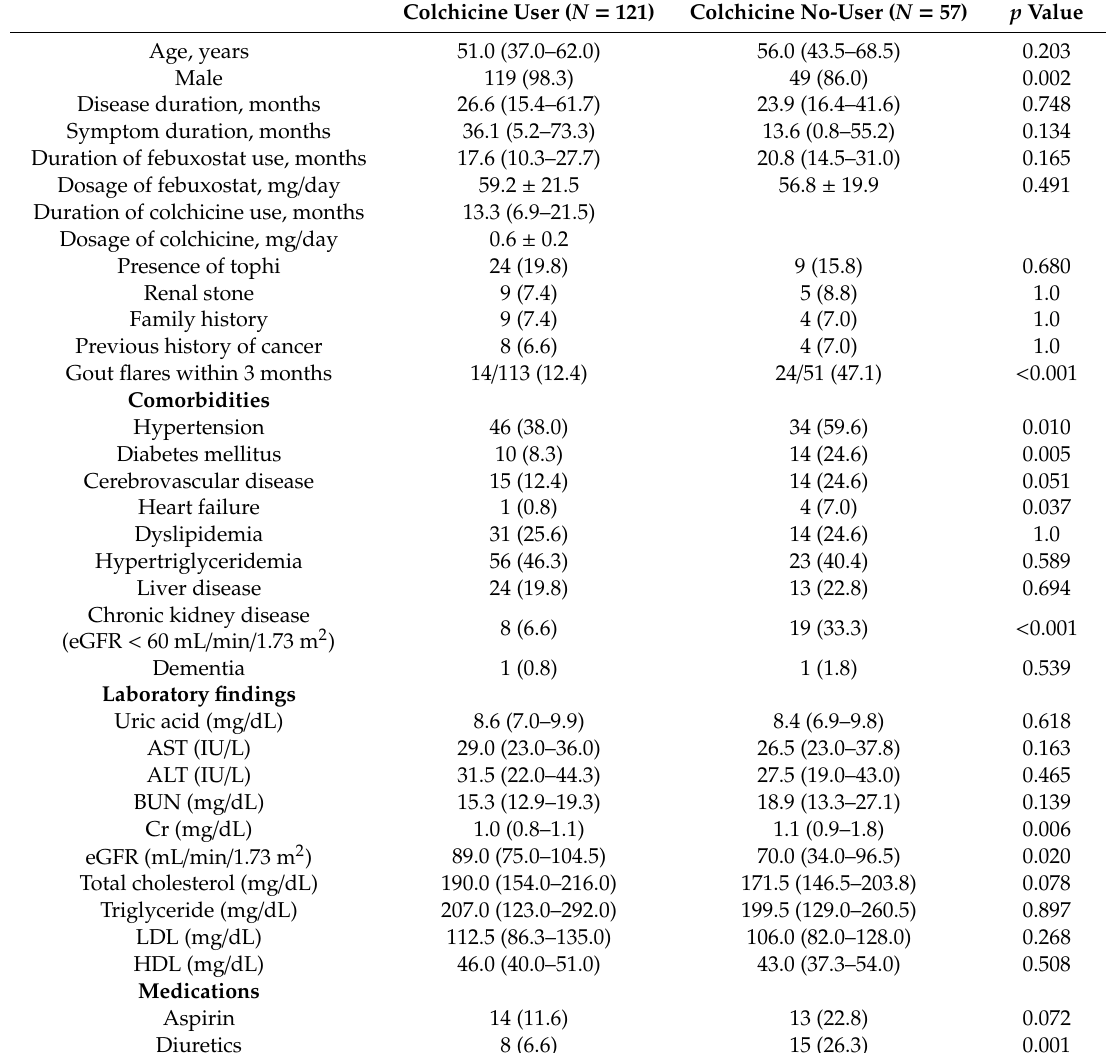
Table 1. Comparison of baseline characteristics according to the use of